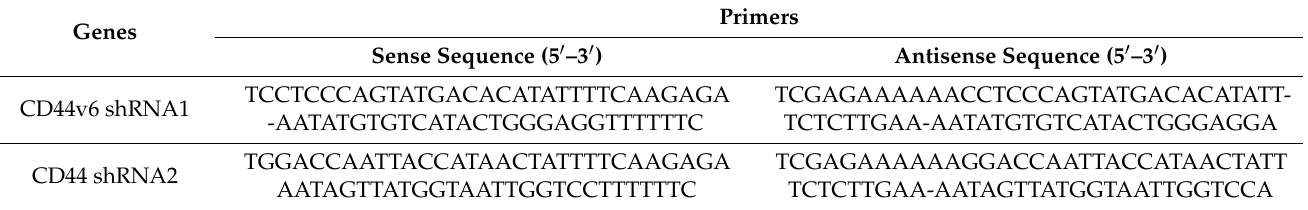
Table 1. shRNA sequence in pSico and pSicoR vectors (https://jacks-lab.mit.edu/protocols). Genes